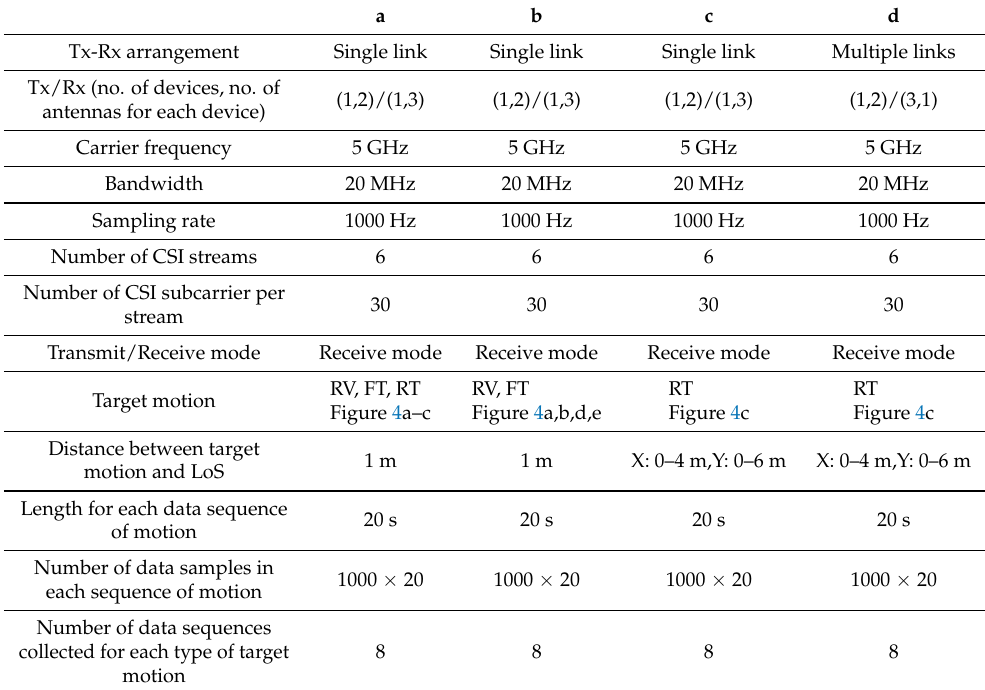
Table 3. Detailed experimental settings and types of target motion used in each scenario.